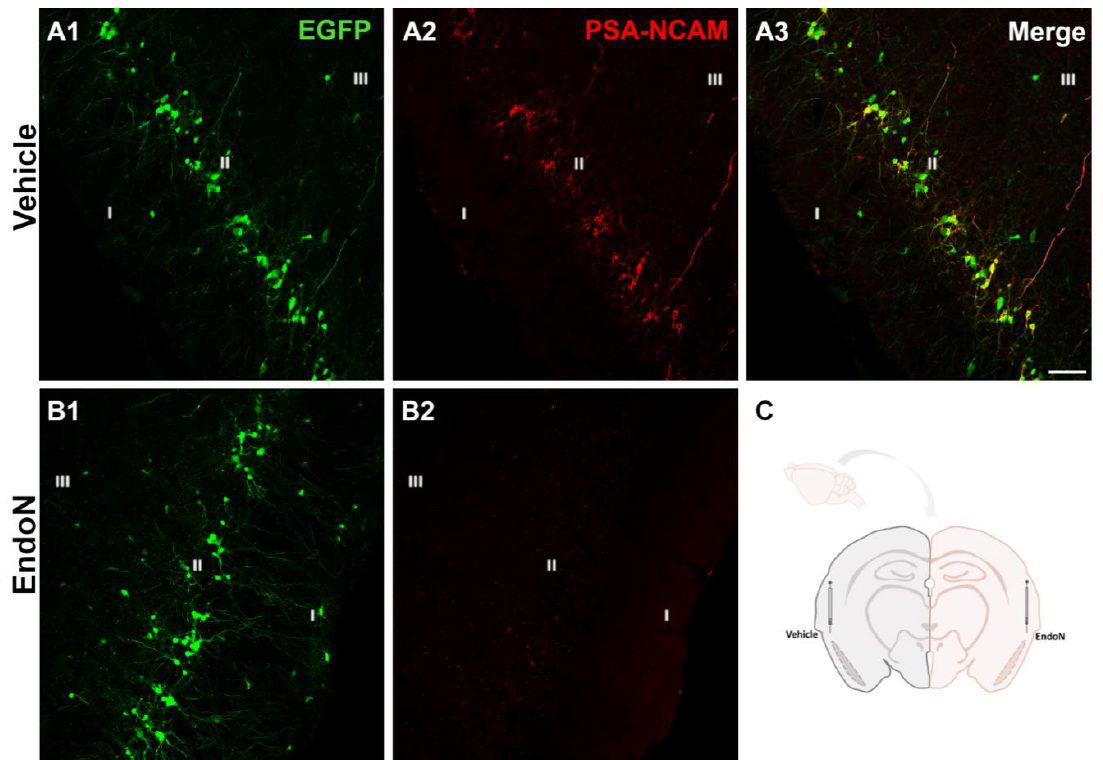
Figure 1. Removal of PSA in the PCX by Endo-N. ( A , B ) Confocal microscopic images of EGFP (green) and PSA-NCAM (red) immunoreactive neurons in the vehicle ( A1 – 3 ) and Endo-N ( B1 , 2 ) injected hemispheres. Note the complete absence of PSA-NCAM expression in the hemisphere injected with Endo-N. ( C ) Drawing showing the hemispheres injected with vehicle (left) or Endo-N (right). Scale bar: 70 µm.